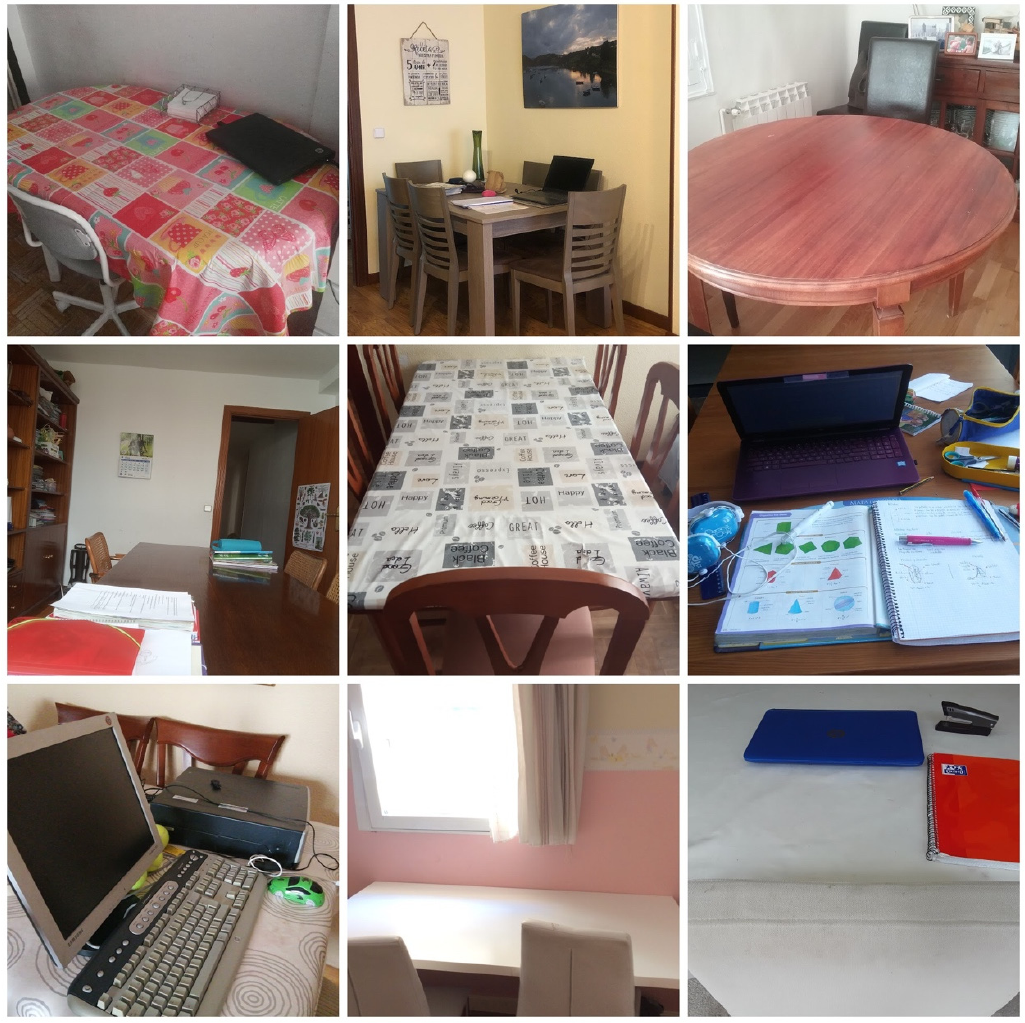
Figure 2. Eventual or roaming spaces for tele-studying, in different home areas.